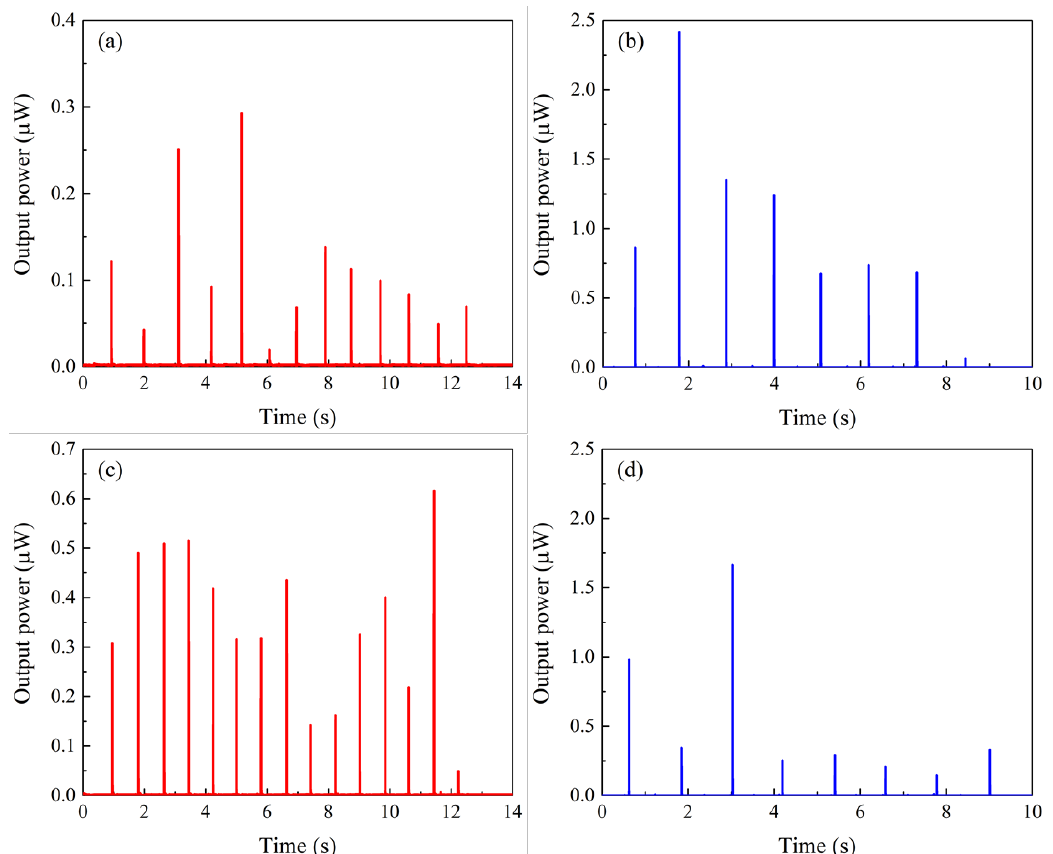
Figure 4. Output power obtained by Fe–Co magnetostrictive fiber integrated shoes; ( a ) during the usual walking of subject 1, ( b ) during the usual walking of subject 2, ( c ) during the walking with legs raised higher in subject 1, and ( d ) during the walking with legs raised higher in subject 2.